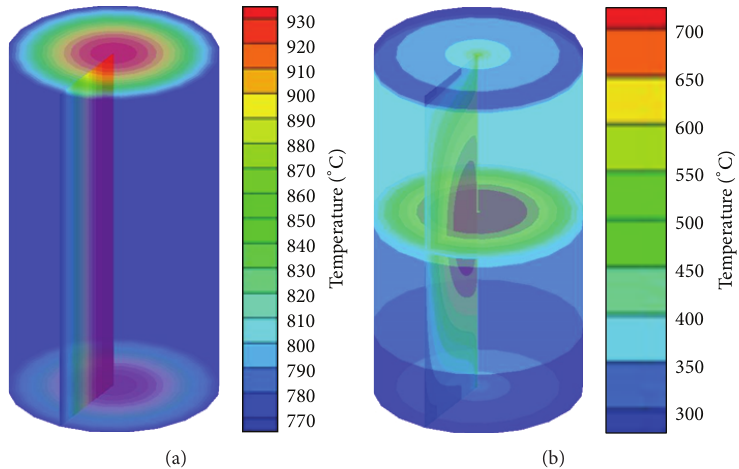
Figure 4: Temperature distribution on solid fuel pin in (a) uniform and (b) nonuniform (sinusoidal) heat generation.